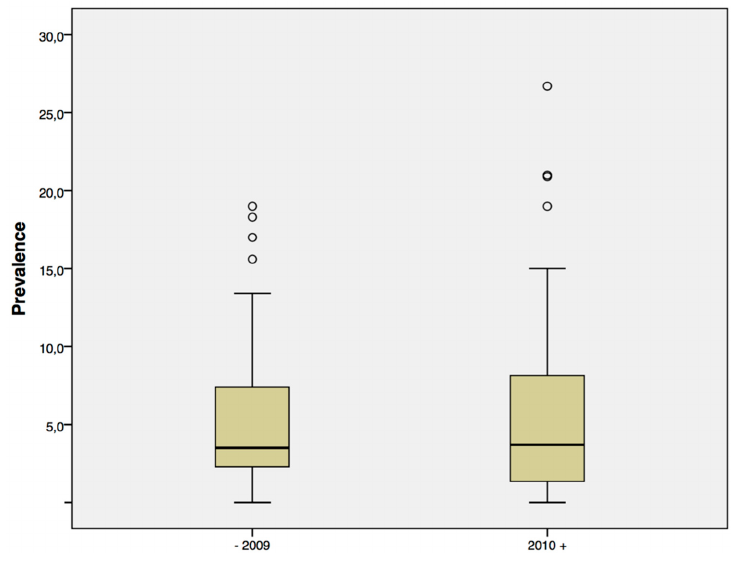
Figure 2. Published prevalences in reports until 2009 and since 2010.